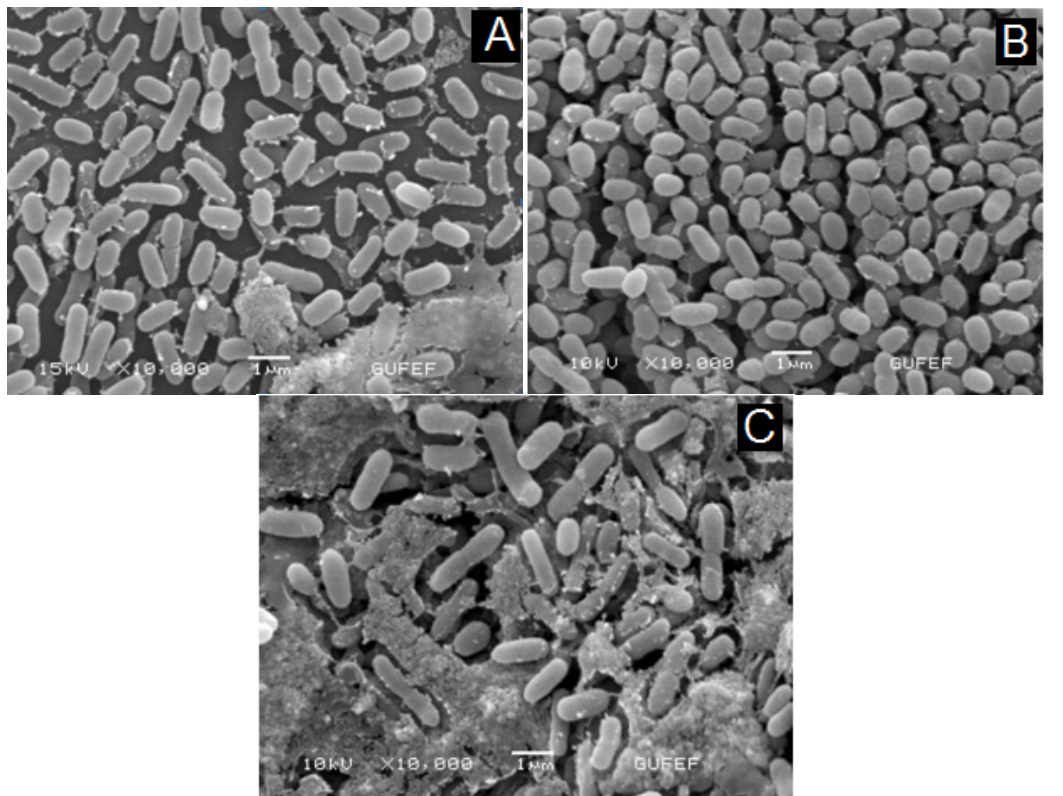
Figure 5. The SEM images of E. coli immobilized with ( A ) 3–MBA; ( B ) 1–DT; ( C ) CTAB– modified magnetic